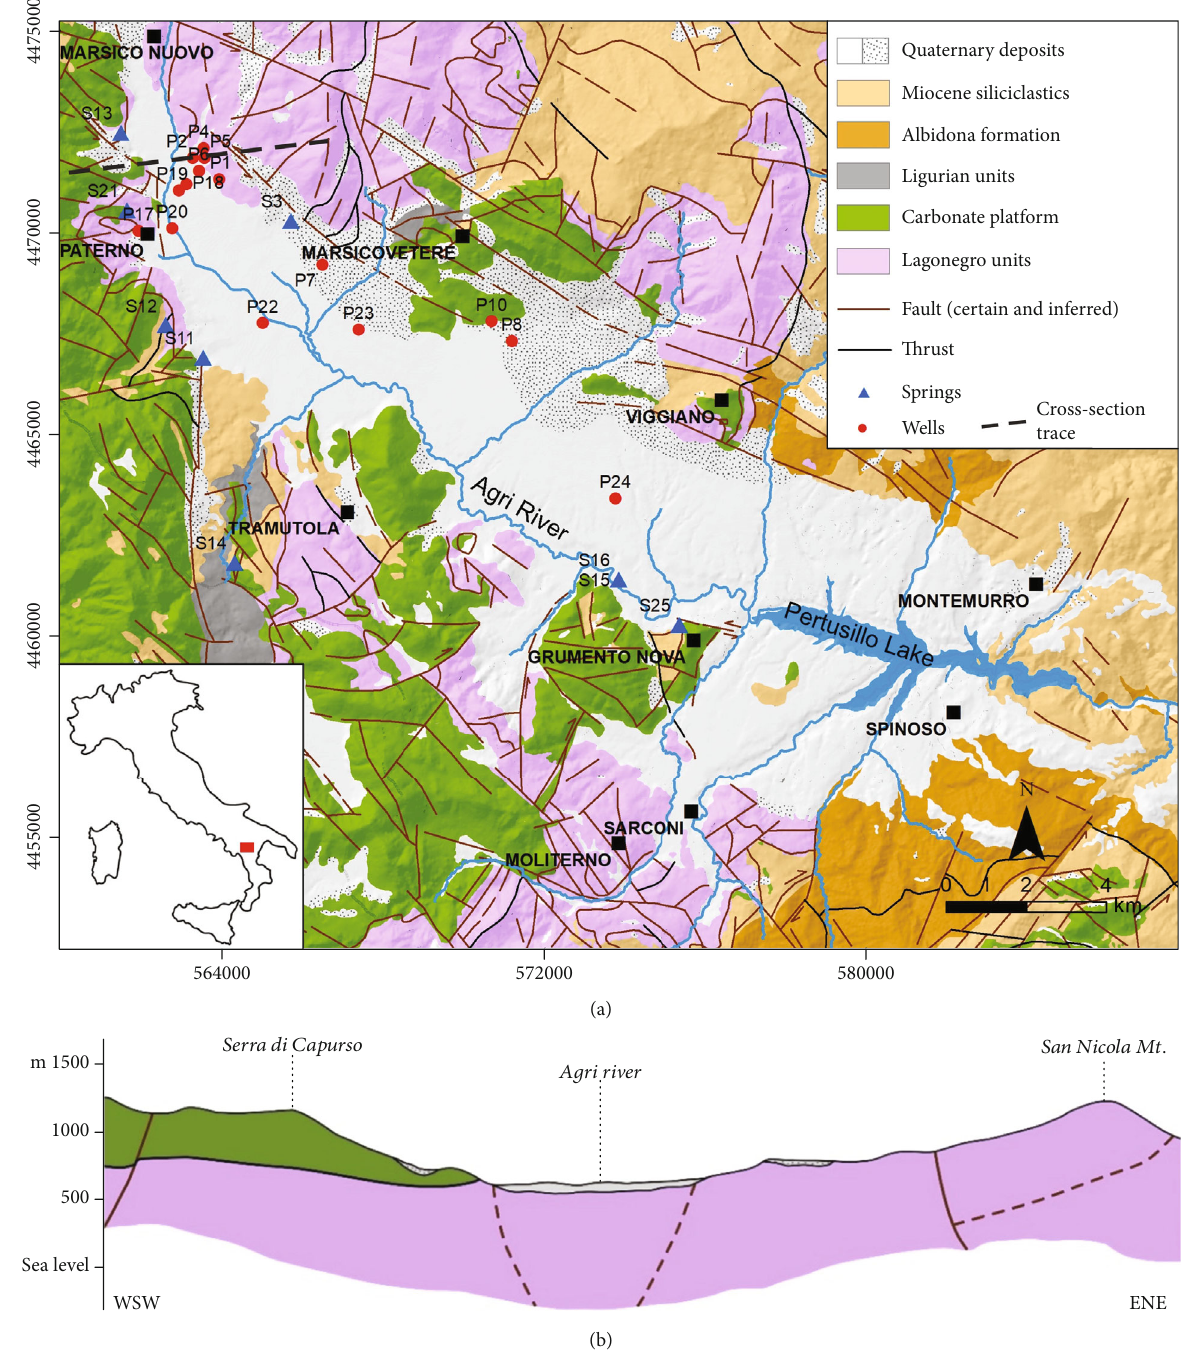
Figure 1: Geological sketch map (a) of the investigated area (modi fi ed after Giocoli et al. [15]) where localization of the sampling sites (springs and wells) is displayed. Schematic cross section (b) of the northern part of study area is drawn (modi fi ed after Carbone et al.